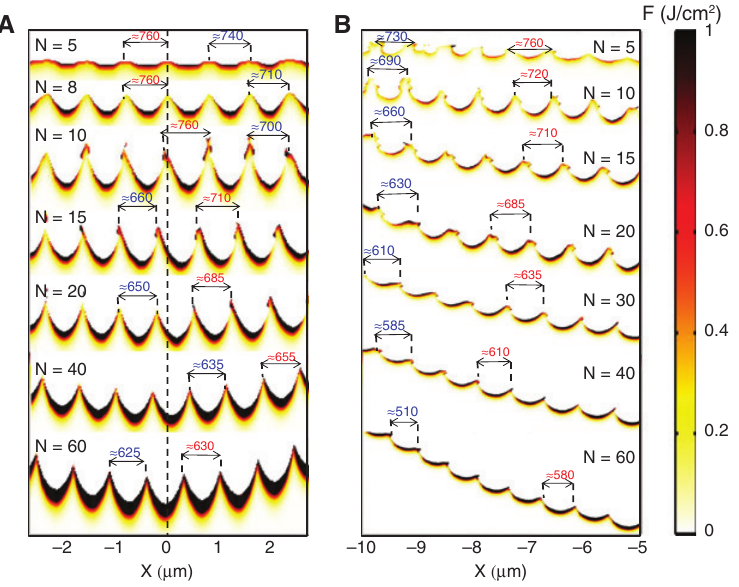
Figure 5: Evolution of ripple periods under multipulse irradiation. Absorbed energy distribution after irradiation of N pulses (A) at the center and (B) at the edges of the ablation crater. The maximum and minimum spacings between consecutive ridges are marked in nanometers by red and blue, respectively. The irradiation conditions are as in Figure